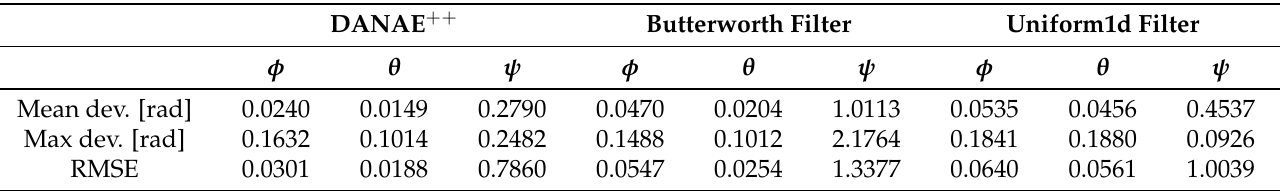
Table 6. OxIO Dataset: evaluation of the performances of DANAE ++ , butterworth and uniform1d filters w.r.t. the GT for the three Euler